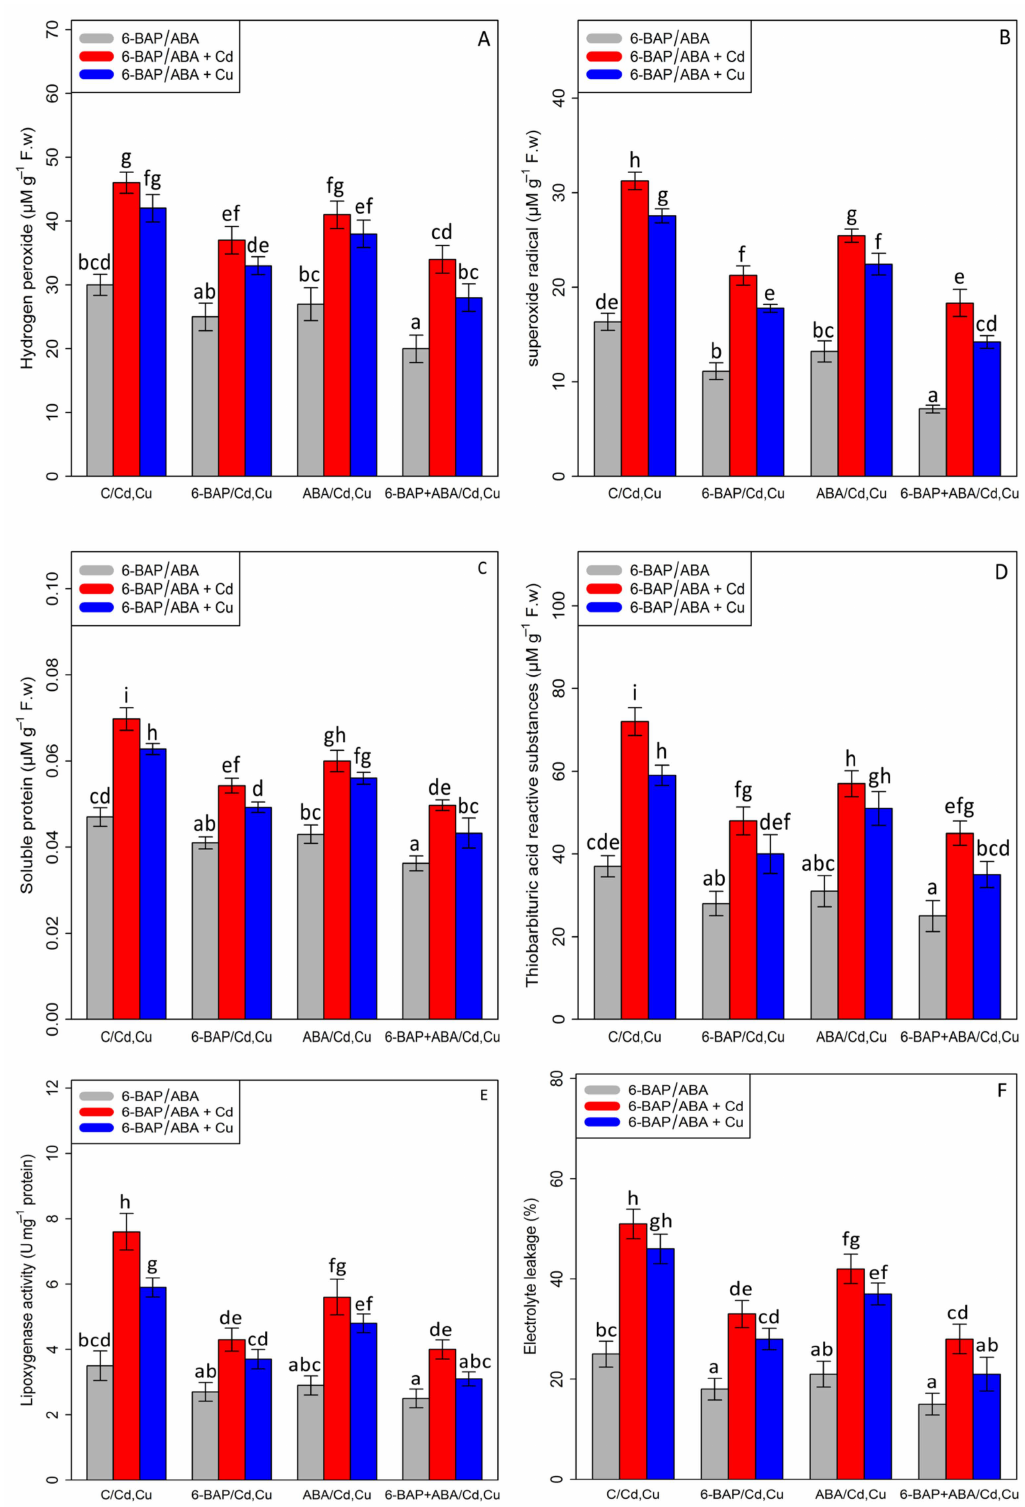
Figure 4. The impact of 6-benzylaminopurine and abscisic acid, alone and in combination, on the content of hydrogen peroxide (H 2 O 2 ) ( A ), superoxide radical (O 2 •− ) ( B ), soluble proteins (SP) ( C ), thiobarbituric acid reactive substances (TBARS) ( D ), lipoxygenase activity (LOX) ( E ), and electrolyte leakage (EL) ( F ) in Pleioblastus pygmaeus exposed to 100 µ M Cd and 100 µ M Cu. In this figure, a, b, c, etc. letters revealed significant differences between treatments based on Tukey’s test ( p <